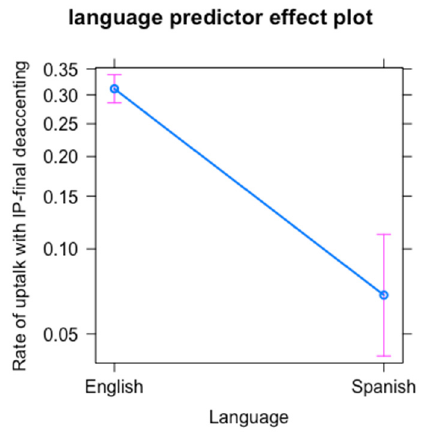
Figure 2. Rate of uptalk with IP-final deaccenting by language.